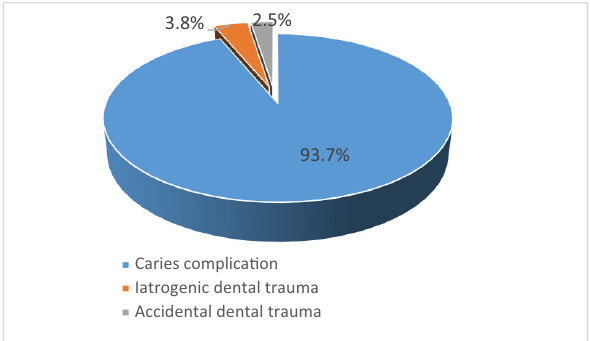
Fig. 2. Etiologic factors involved in dental cellulitis.